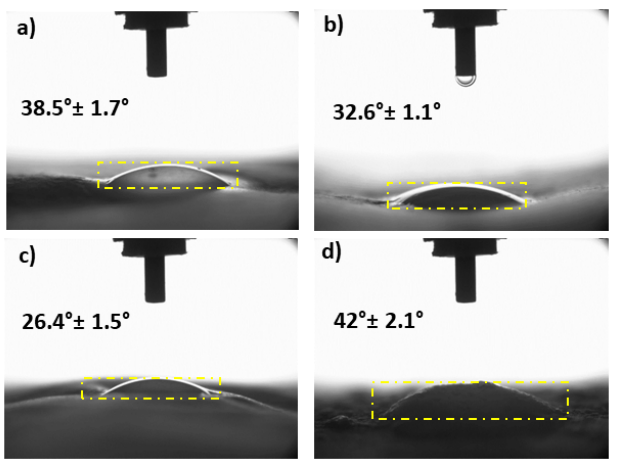
Figure 8. Water contact angle properties of the 13% PVA ( a ), 13% PVA/0.5% GEL ( b ), 13% PVA/0.5% GEL/3% Ps ( c ), 13% PVA/0.5% GEL/5% Ps ( d ).